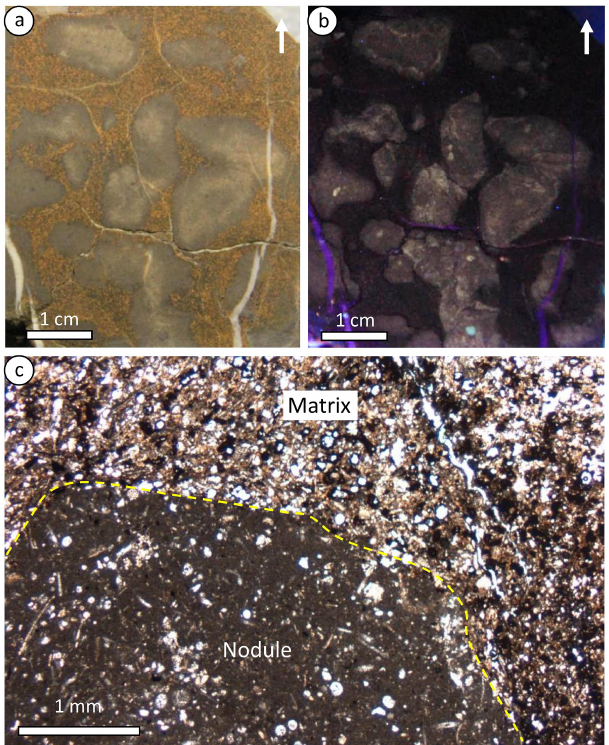
Figure 6. Facies 3 (F3): nodular limestone. (a, b) Vertical sec- tion under natural (a) and UV light (b) ; arrows point upward. (c) Photomicrograph showing contact between a nodule and ma- trix (marked by yellow dashed line). Grain packing in the matrix is denser than in the nodule, suggesting cementation of the nodule prior to